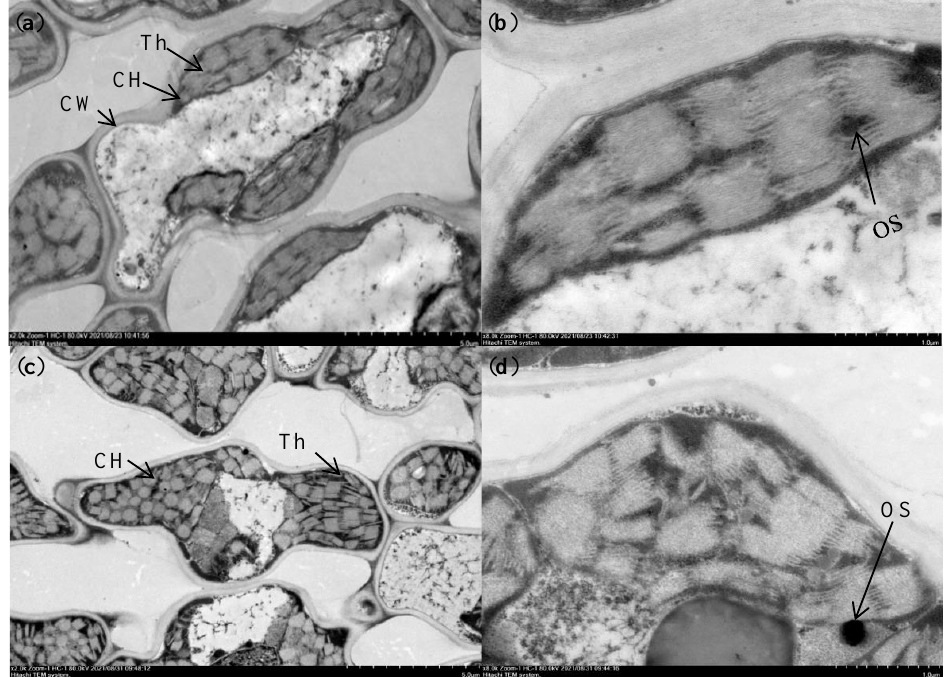
Figure 2. Chloroplast ultrastructure of leaves of C1 and G164 rice varieties. Note: ( a , b ) represent C1; ( c , d ) represent G164; Ch: chloroplast; CW: cell wall; Th: thylakoid; OS: osmiophilic granule.